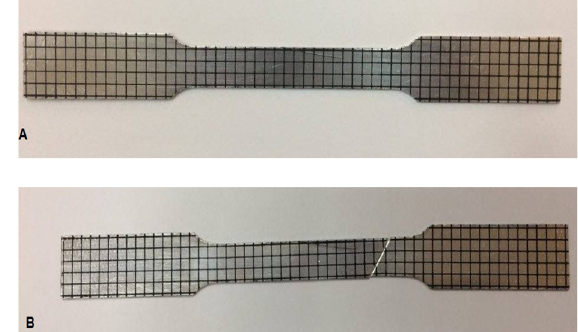
Fig. 2. True stress and true strain curve.